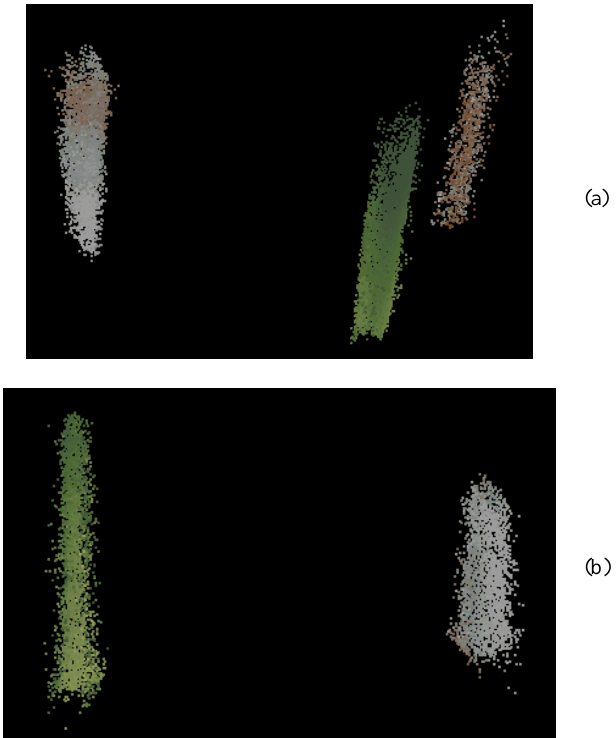
Figure 5: Point clouds generated by bundle adjustment and ATE in LPS using images from the (a) right and (b) left .